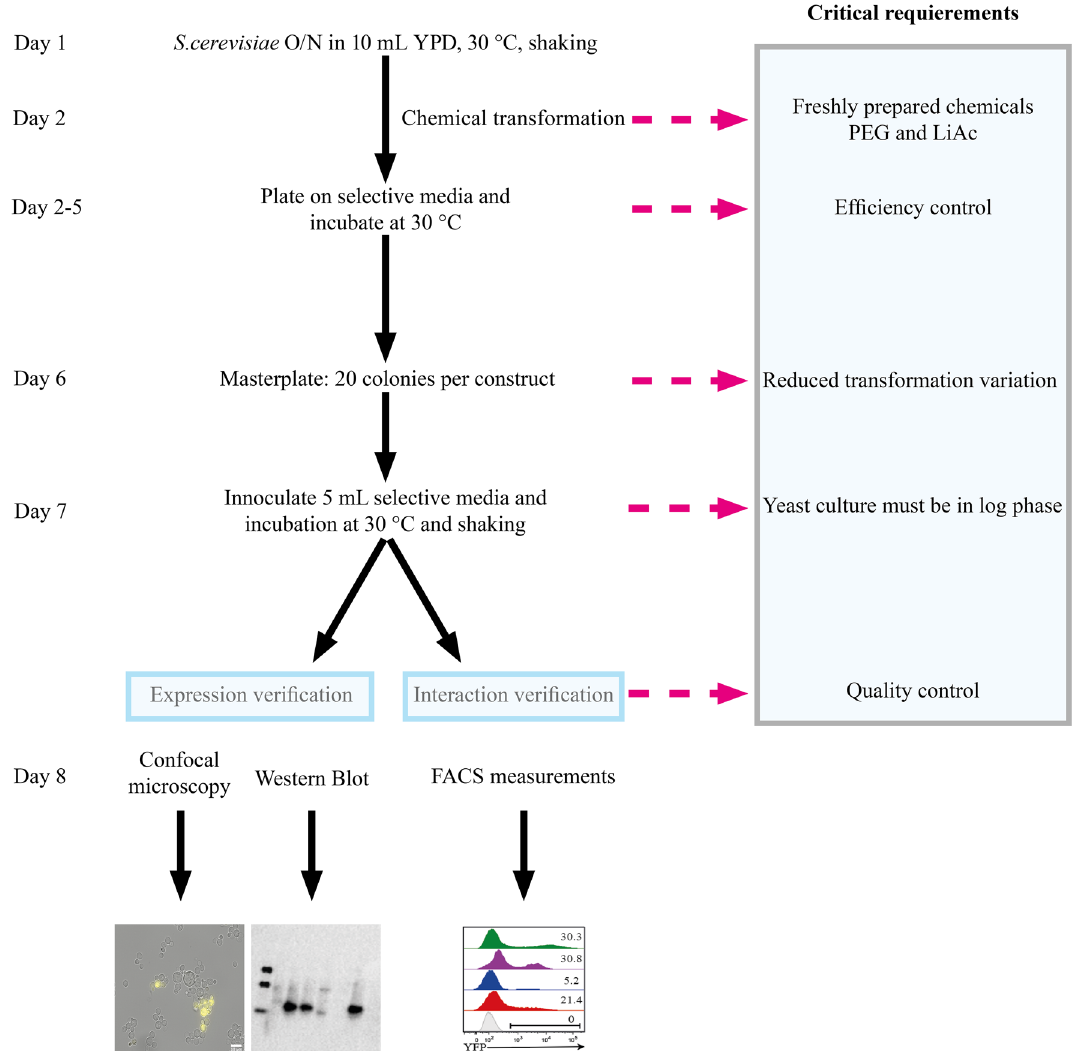
Figure 1. Experimental design of a standardized cell preparation for expression and interaction analysis of BiFC complexes produced in Saccharomyces cerevisiae cells. The schedule shows that the whole screening process is completed in less than 14 days, emphasizing critical